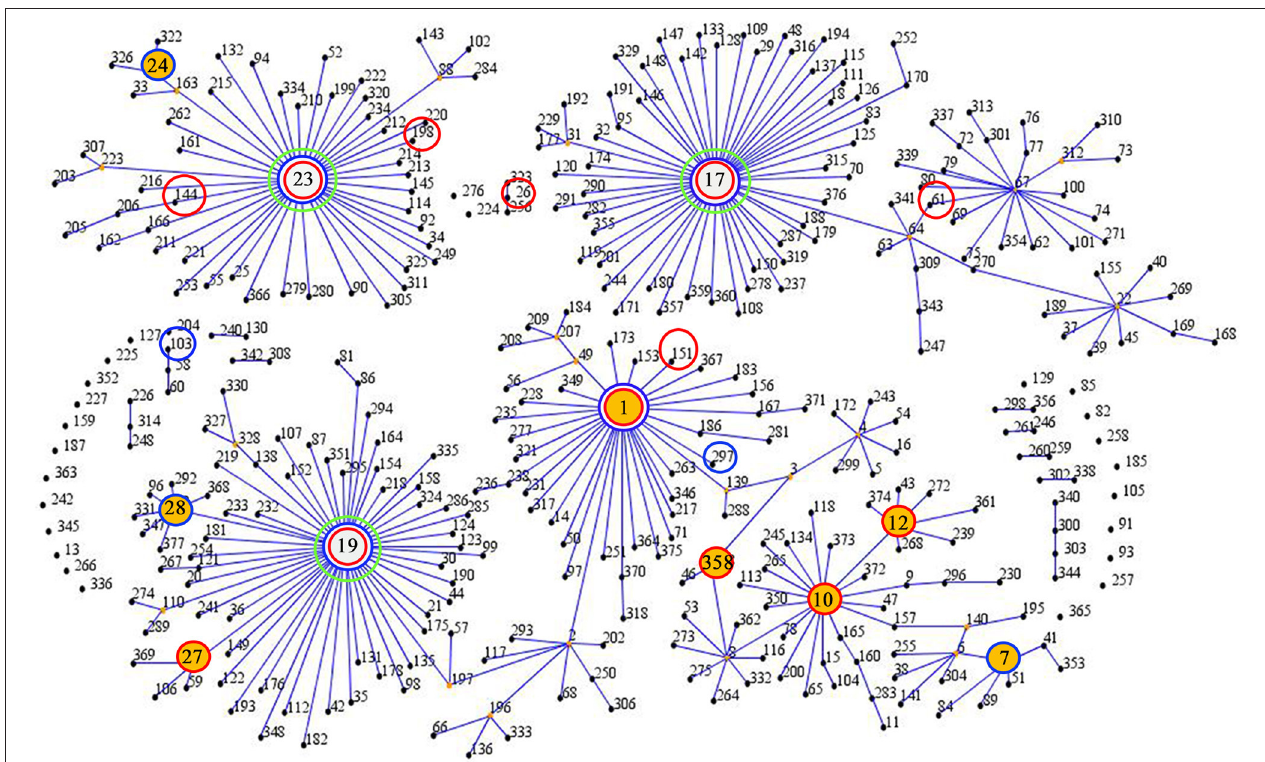
FIGURE 1 | eBURST analysis of S. agalactiae using all STs available in the MLST database as of January 2016. ST nodes: green circles indicate a group founder, yellow circles indicate a sub-group founder, red circles indicate STs isolated from community samples, and blue circles indicate STs isolated from hospital